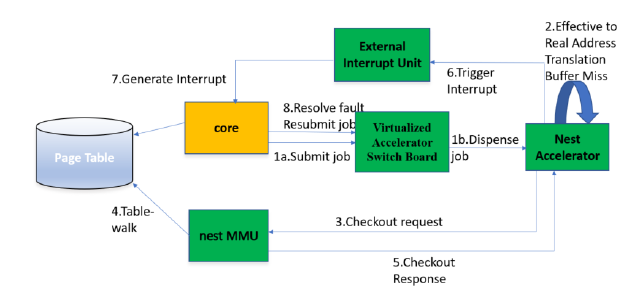
Figure 2. Va lidation test